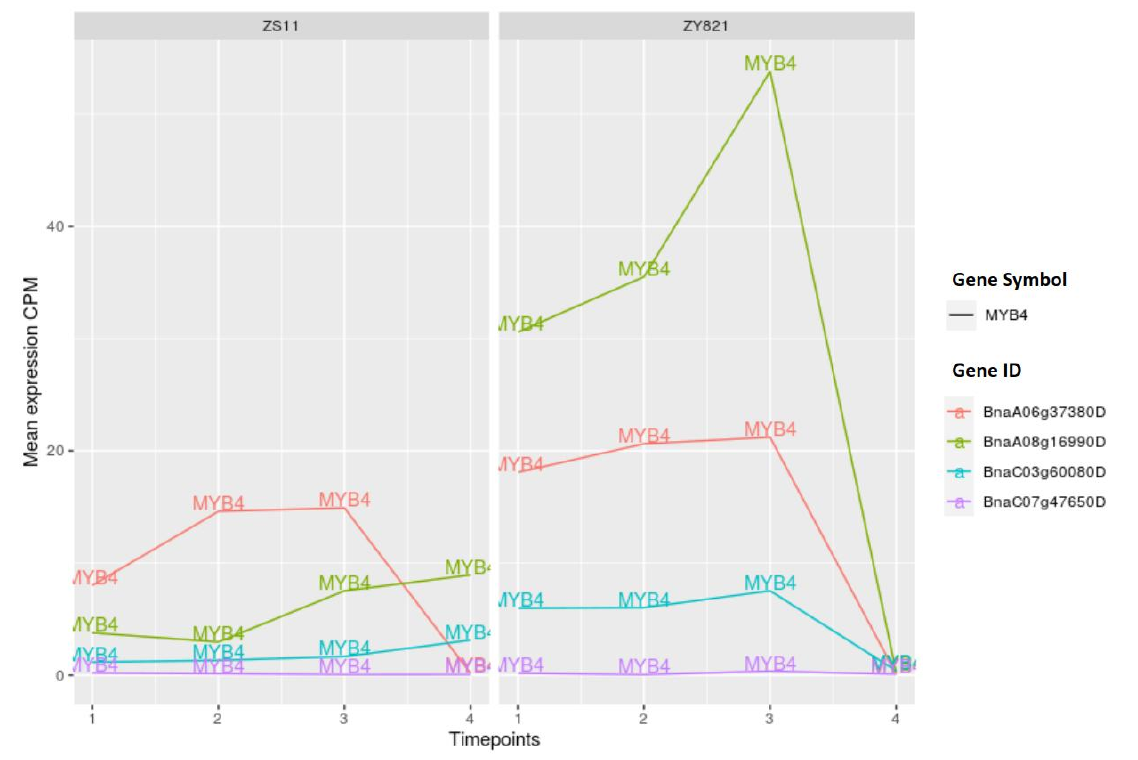
Figure 10. Expression values of MYB4 orthologous genes. Time points 1 to 4 represents day 7, day 10, day 15, and day 45 after